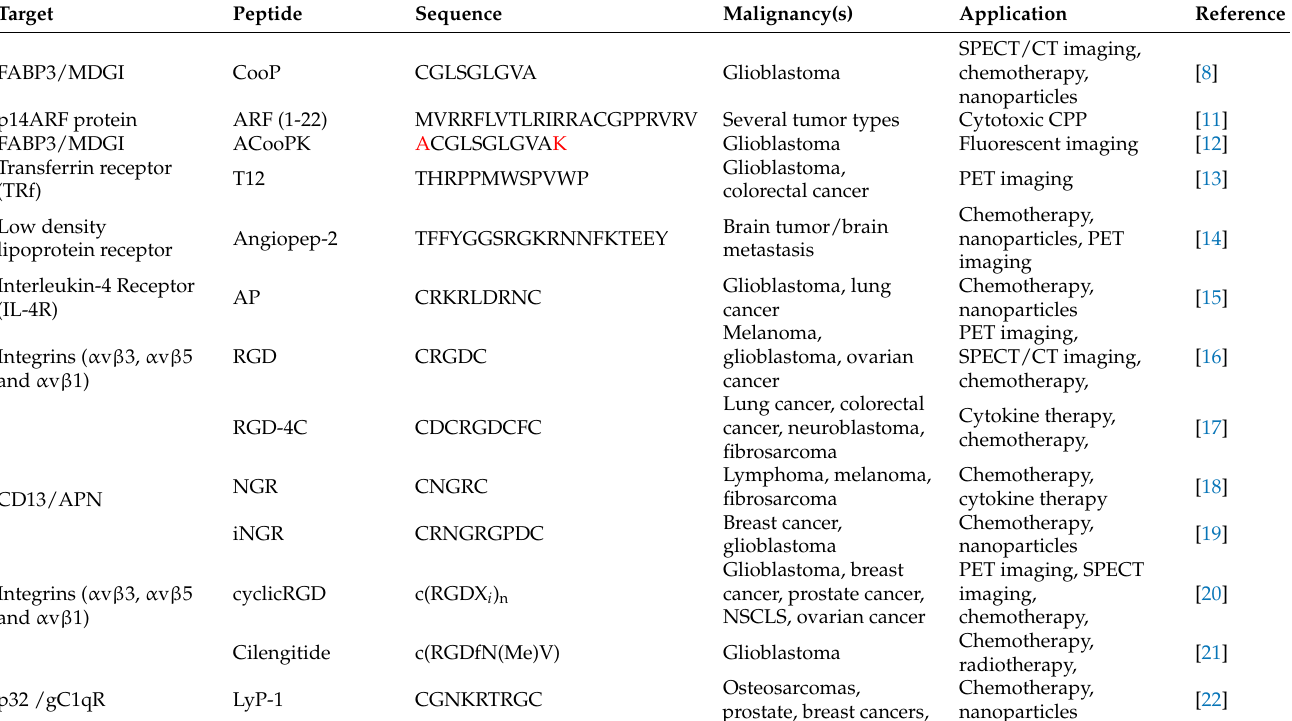
Table 1. Sequences of the tumor homing peptides and their target proteins, malignancies, and applications. Target Peptide